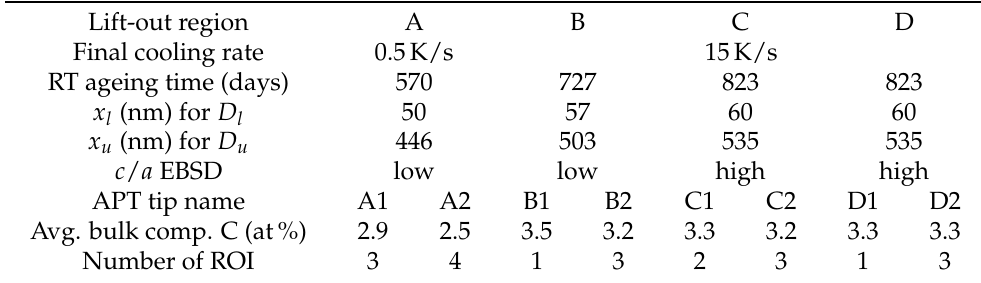
Table 1. Overview of final cooling rate, ageing time, mean expected diffusion distance x i , local martensite tetragonality c / a , average bulk carbon content and number of ROI for lift-out regions A–D and the two respective APT tips per